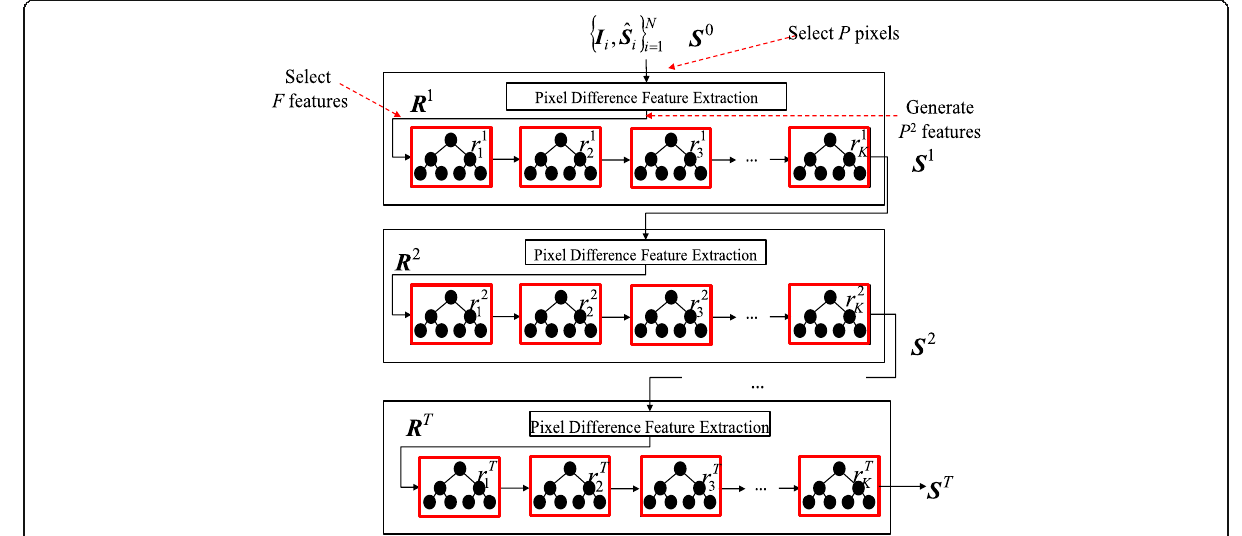
Fig. 1 Flow diagram of the explicit shape regression method